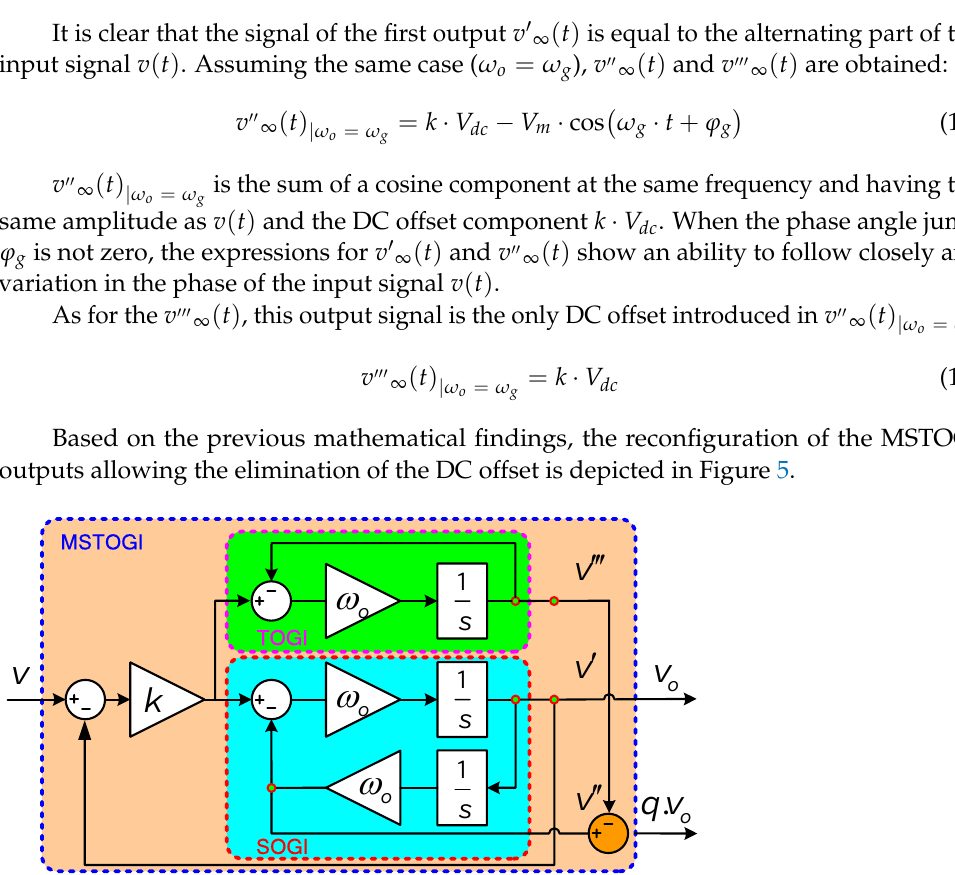
Figure 5. Block diagram of MSTOGI configuration.